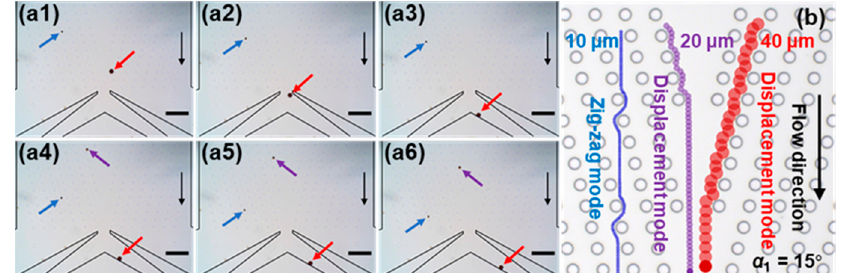
Figure 5. ( a1 – a6 ) Snapshots of the movement of the magnetic beads at the near outlet at the first stage. The time interval is approximately 2.5 s. The 10 μ m, 20 μ m and 40 μ m magnetic beads are indicated by blue, purple and red arrows, respectively. Black arrows indicate the flow direction. Scale bar is 200 μ m. ( b ) Schematic illustration of the trajectories of three kinds of magnetic beads at α 1 = 15°.